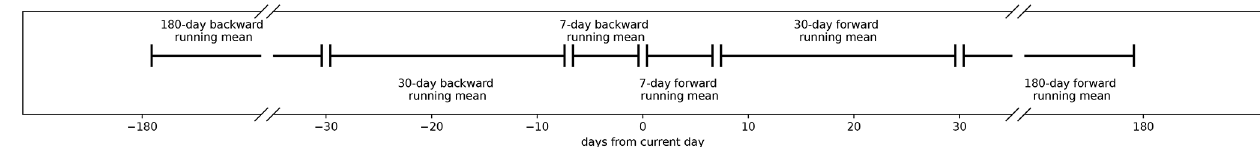
Algorithm 1 Pseudo-code algorithm of the CLIMFILL